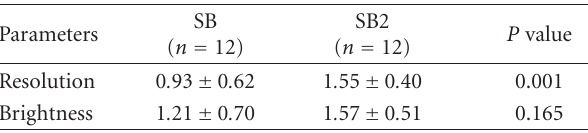
Table 3: Subjective scoring of resolution and brightness on SB and SB2